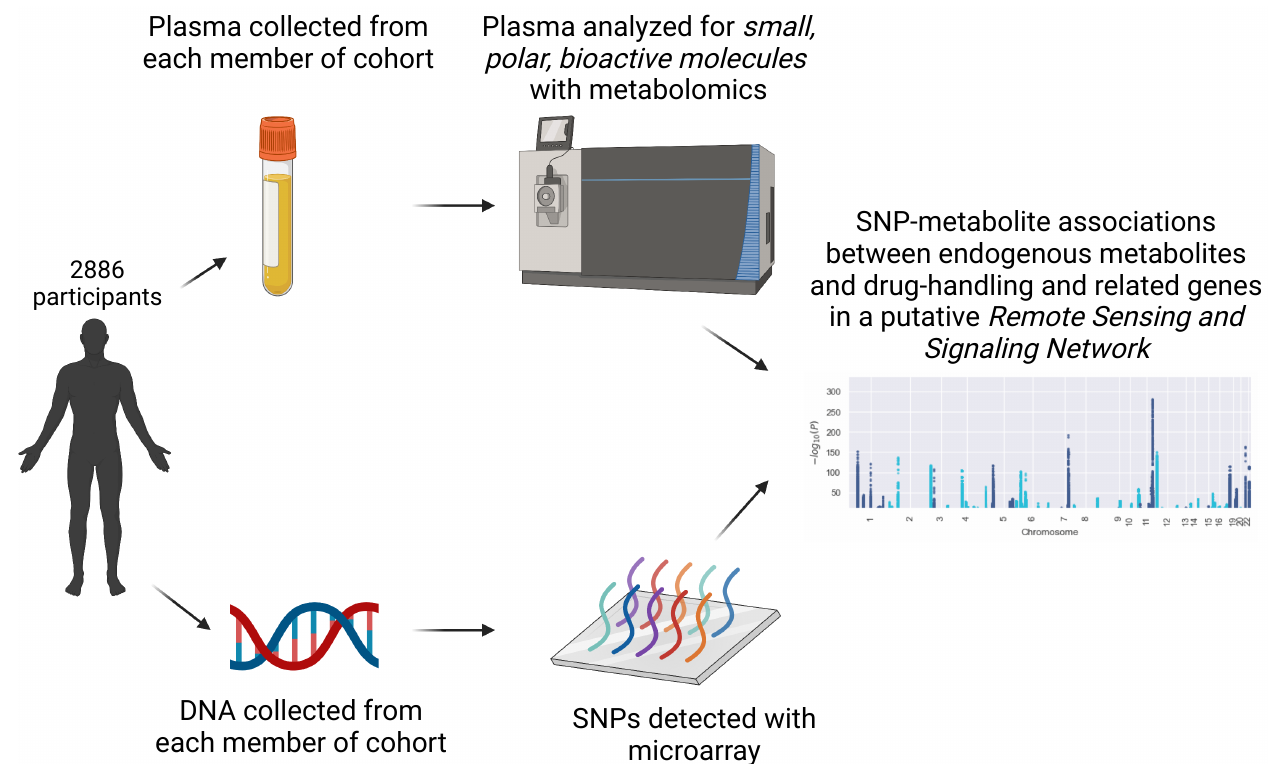
Figure 1. Schematic for data acquisition and subsequent analysis. Plasma was collected from each patient and analyzed by liquid chromatography/mass spectrometry, which sought to capture small, polar, bioactive molecules presumed most likely to be involved in signaling via cell surface and other receptors. DNA was collected from participants and SNPs within a subset of genes were associated with the levels of plasma